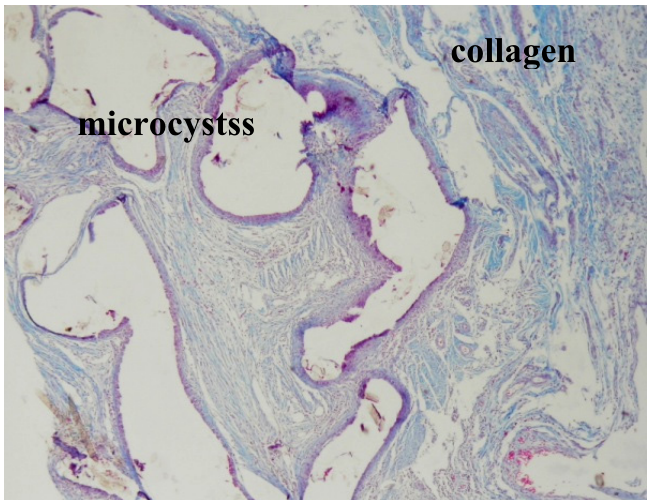
FIGURE 7 - Light photomicrograph of the left inguinal region of dog number 12 (latex biomembrane with 0.5-mm porous polyamide) obtained on the 28th day after surgery. There is deposition of organized collagen and microcysts with biomembrane fragments are observed. There was no fibrosis (Masson trichrome,